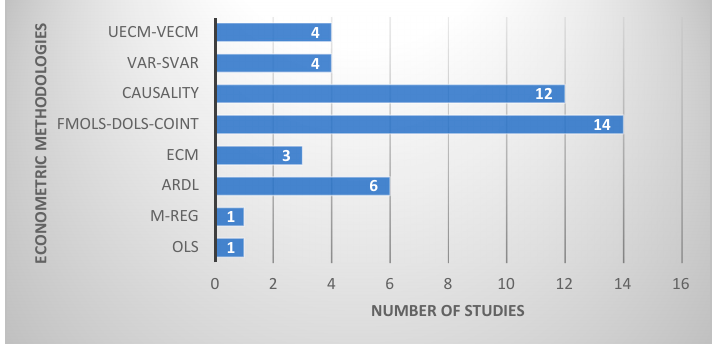
Figure 4. The econometric methodologies used in relation to the number of studies on the energy– growth nexus .